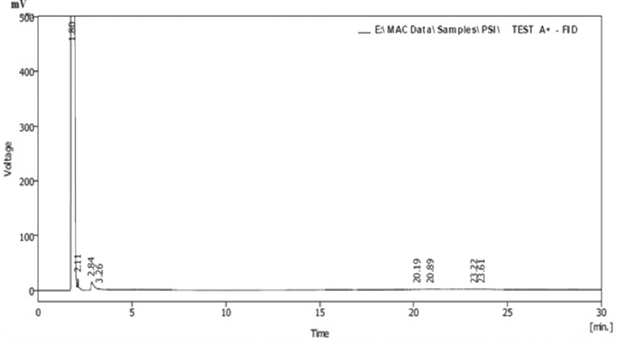
FIGURE 1 - GC/MS Chromatogram obtained for the methanol fraction of A. squamosa leaf